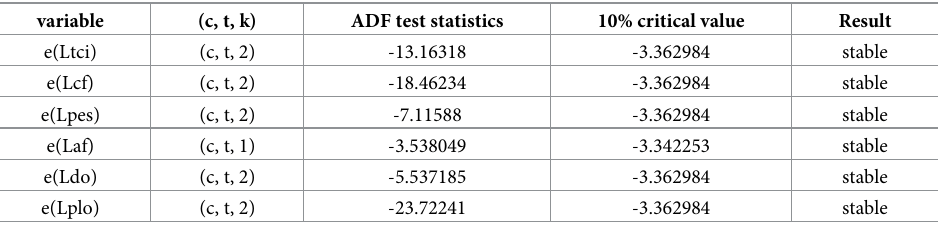
Table 6. Result of ADF unit root test of